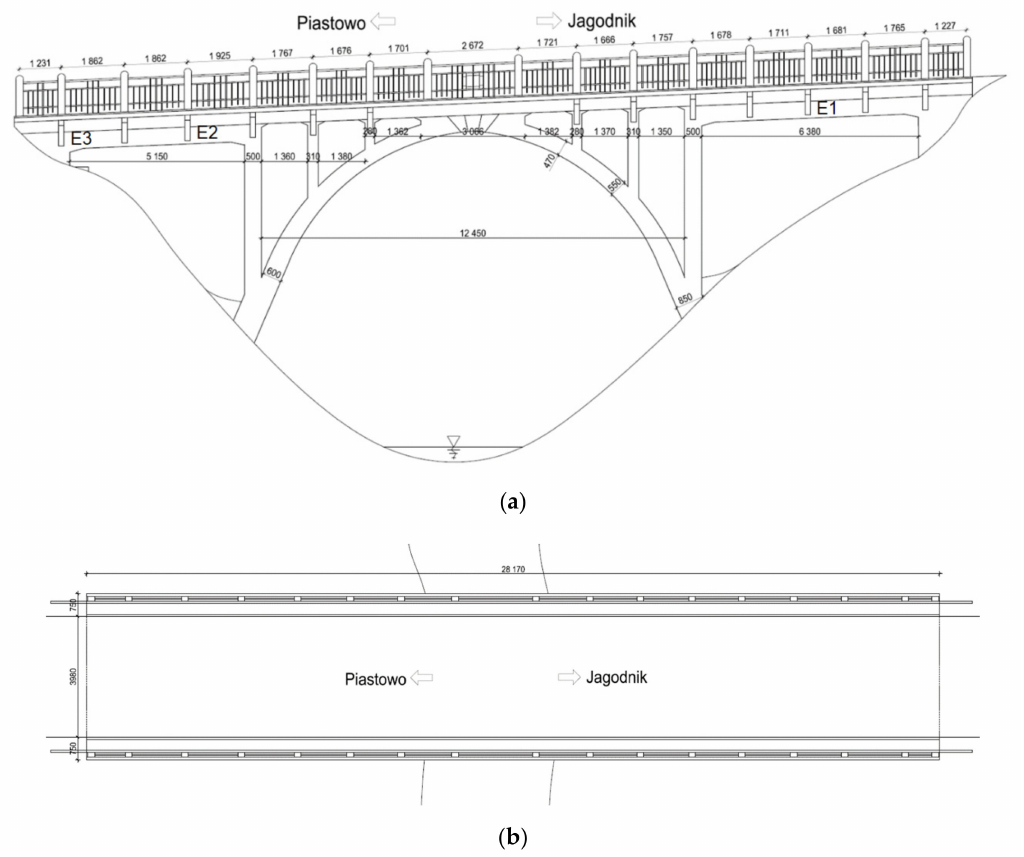
Figure 1. Jagodnik arch bridge before reconstruction (dimension units—mm): ( a ) Side view; ( b ) view from